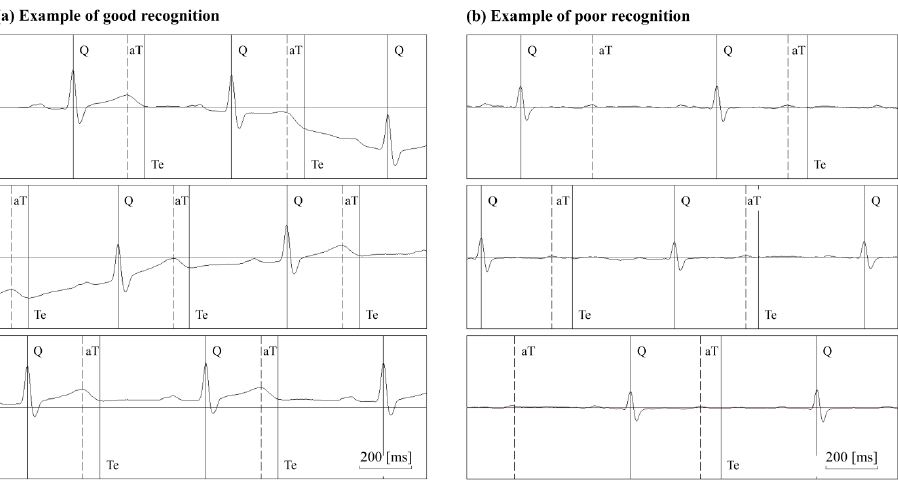
Figure 4. Examples of automated ECG recognition measurement. The Q wave, apex of the R wave, apex of the T wave (aT), and T-wave end (Te) were recognized on consecutive electrocardiograms. ( a ) Even in the presence of baseline drifting, aT and Te are precisely recognized. ( b ) A flattened T wave makes recognition of aT and Te difficult.